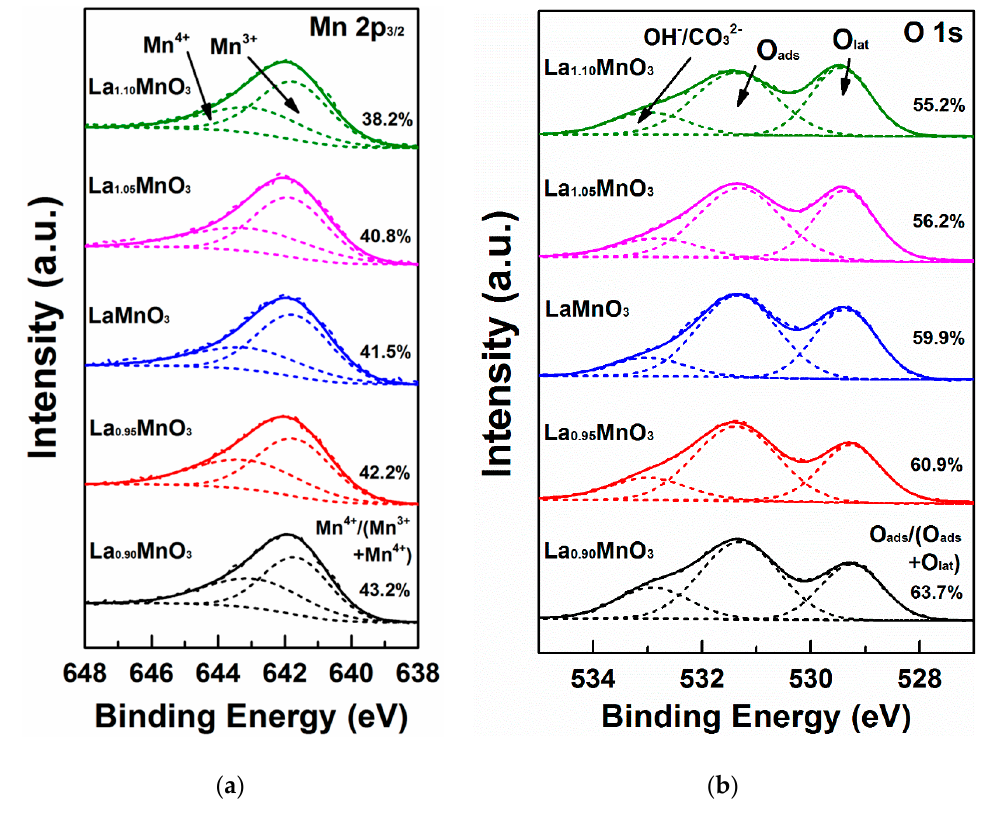
Figure 2. XPS spectra of La x MnO 3 catalysts: ( a ) Mn 2p 3/2 ; and ( b ) O 1s.